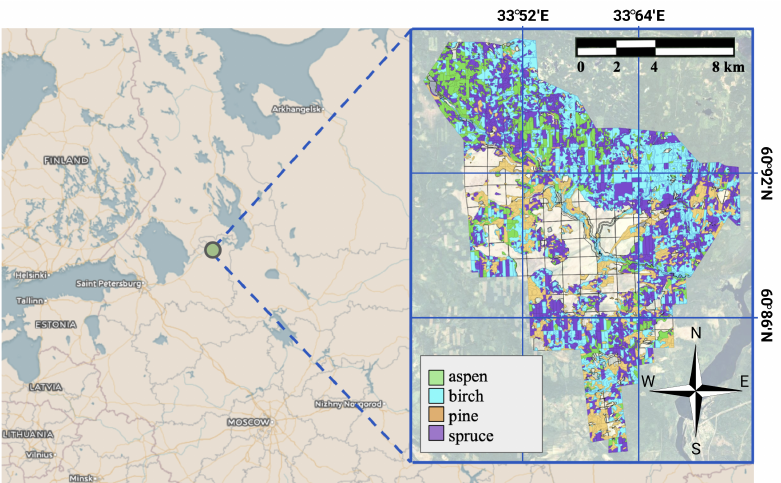
Figure 1. Region of interest. Enhanced RGB bands of Sentinel-2 image (tile id is